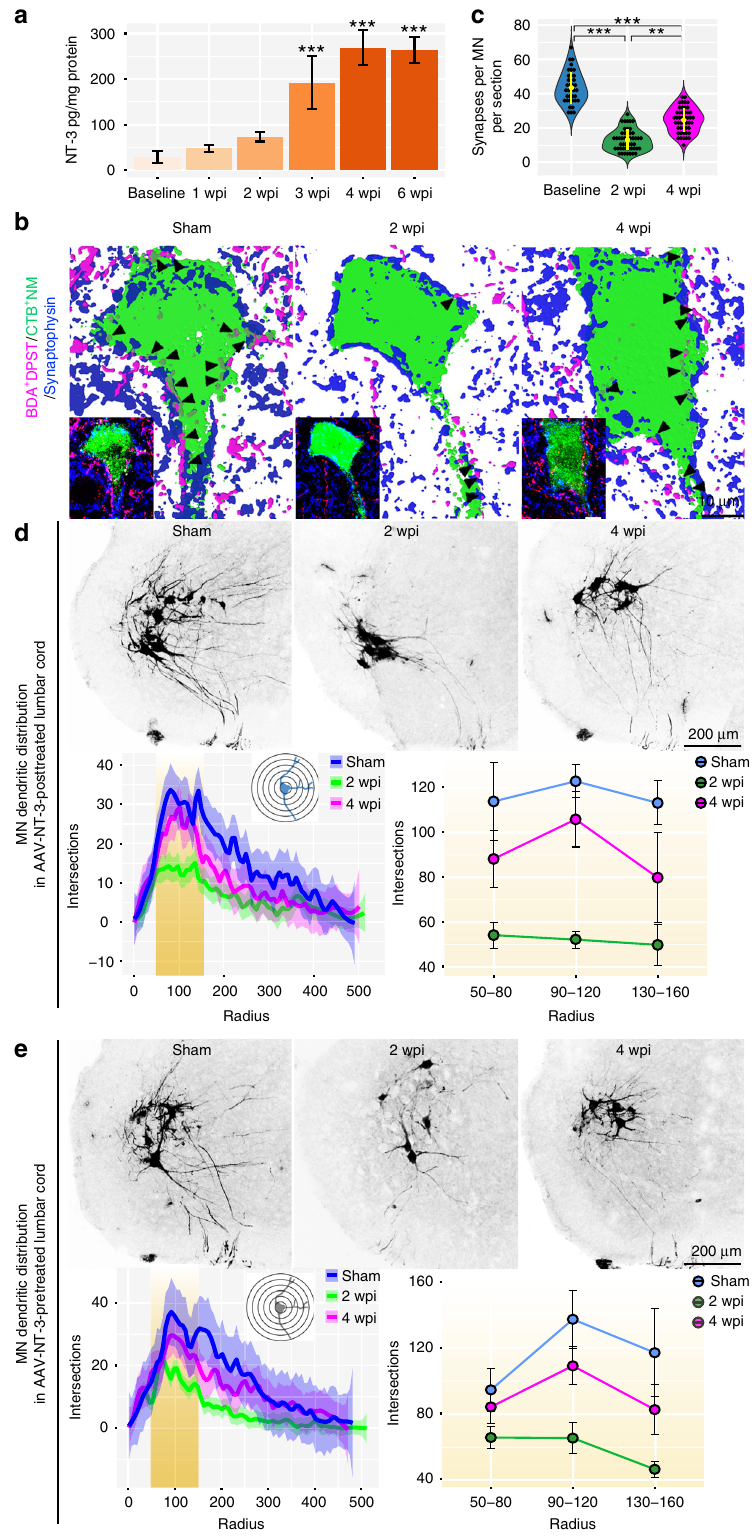
that innervate the lumbar neurocircuit, as well as the fi rst study to reveal a critical role of descending propriospinal-lumbar MN circuit for enabling motor control after a rostral, contusive SCI. Locomotor movements in vertebrates are not only generated by activities in spinal neurons themselves but also regulated by descending pathways from supraspinal areas 1,2 . SCIs